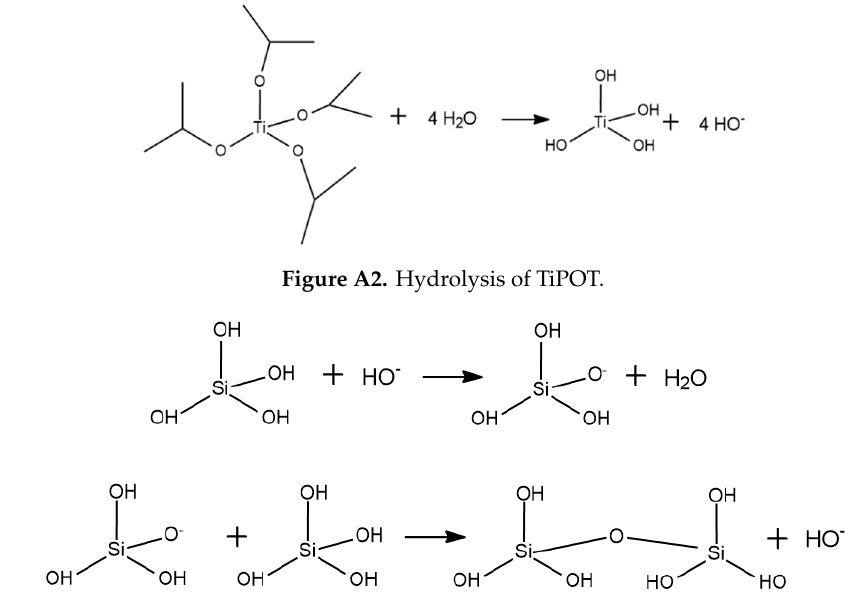
Figure A1. Hydrolysis of TEOS.